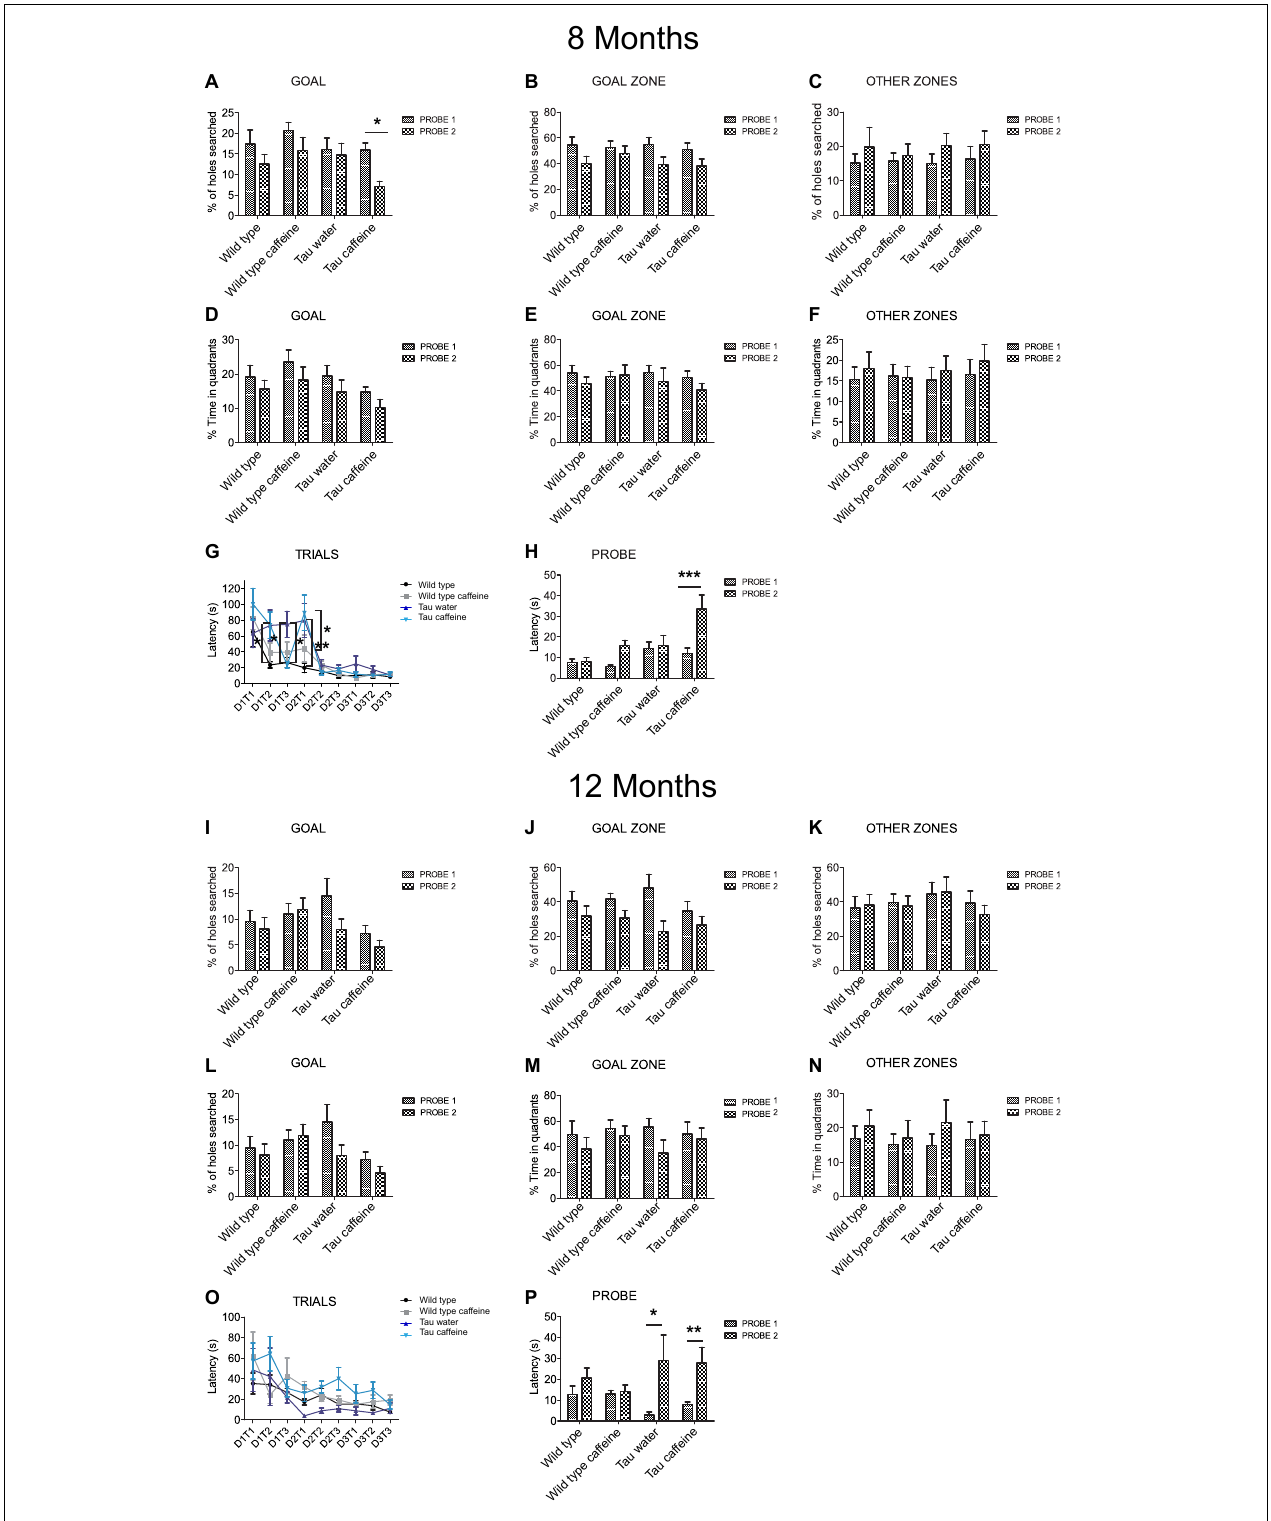
FIGURE 4 | Investigation of early-life exposure to caffeine on learning and memory performance. Barnes maze test was performed in 8 (A–G) and 12 (I–O) month-old mice. Training was performed for 3 days (D1, D2, D3), with three trials (T1, T2, T3) per day. For 8 and 12 month-old mice, the% of holes searched in